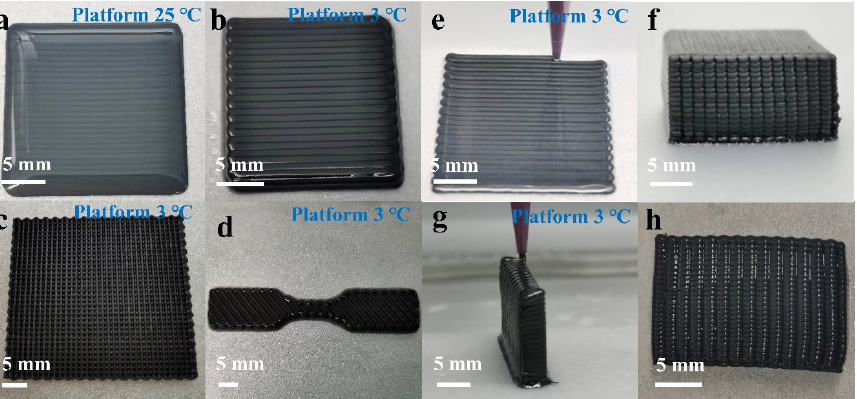
Figure 3. Printing 20 mm × 20 mm × 1 mm samples with temperatures at ( a ) 25 °C and ( b ) 3 °C; ( c ) 40 mm × 40 mm grid samples and ( d ) dumbbell shape samples formed at 3 °C; ( e ) 20 mm × 20 mm × 10 mm samples in the printing process and ( f ) after completed printing; ( g ) the printing process and ( h ) the printed sample of 4 mm × 20 mm × 12 mm. The above applied inks are all 10 wt% GNPs- TPU.